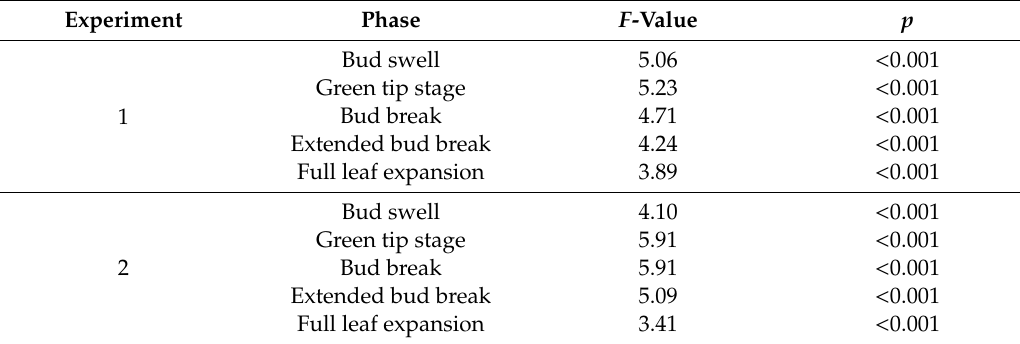
Table 2. Parameter ( F -value and p ) of one-way analysis of variance in the timings of each bud break phase in the two experiments using provenances as factor.